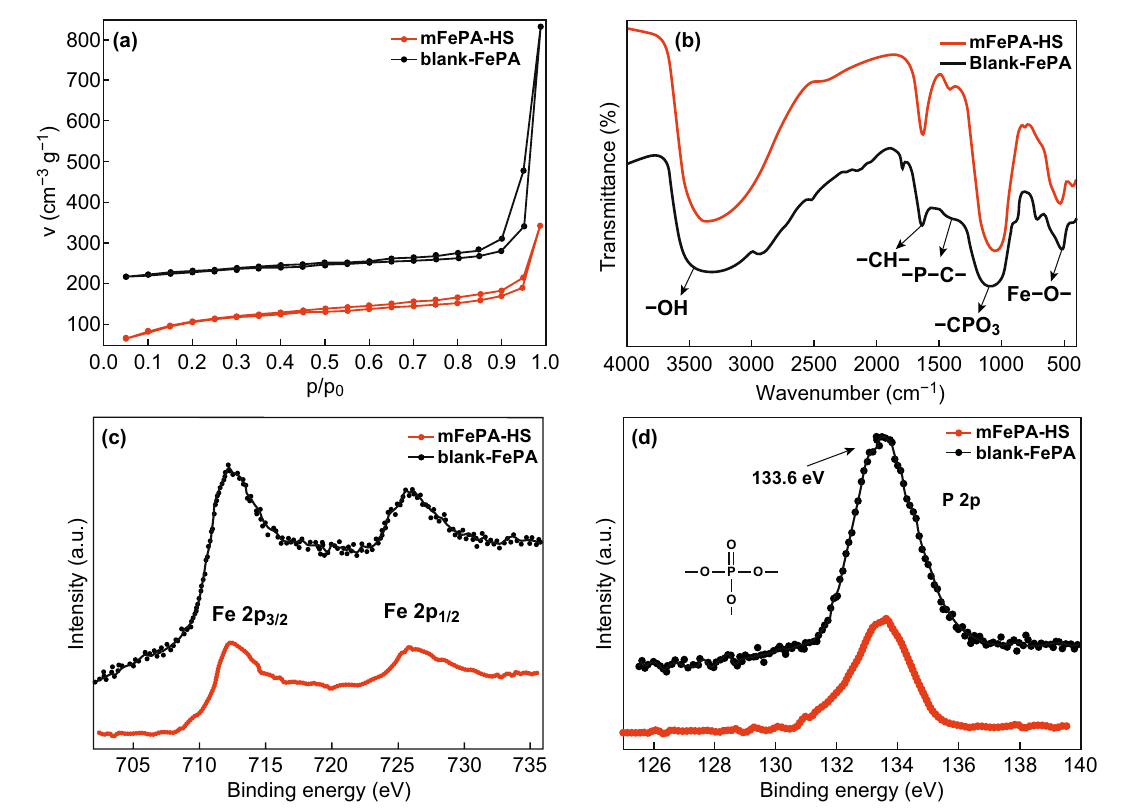
Fig. 3 Characterization of mFePA-HS. a N 2 adsorption–desorption isotherms of mFePA-HS and blank-FePA; the curve of blank-FePA has been moved up for 200 cm −3 g −1 . b FTIR spectra of the mFePA-HS and blank-FePA. c XPS spectra of Fe 2 p . d XPS spectra of P 2 p